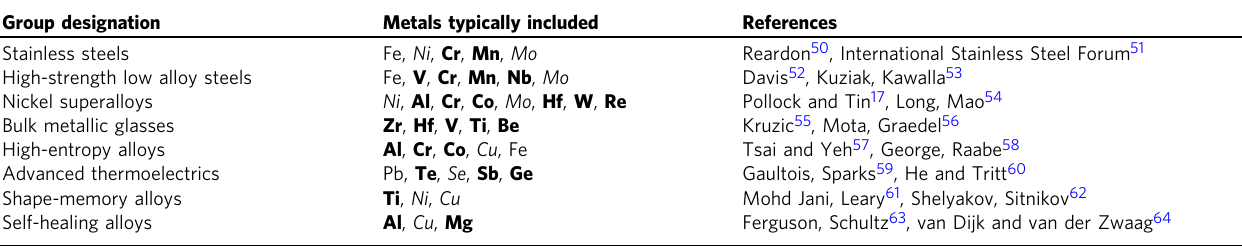
Table 1 Examples of the diverse compositions of many modern